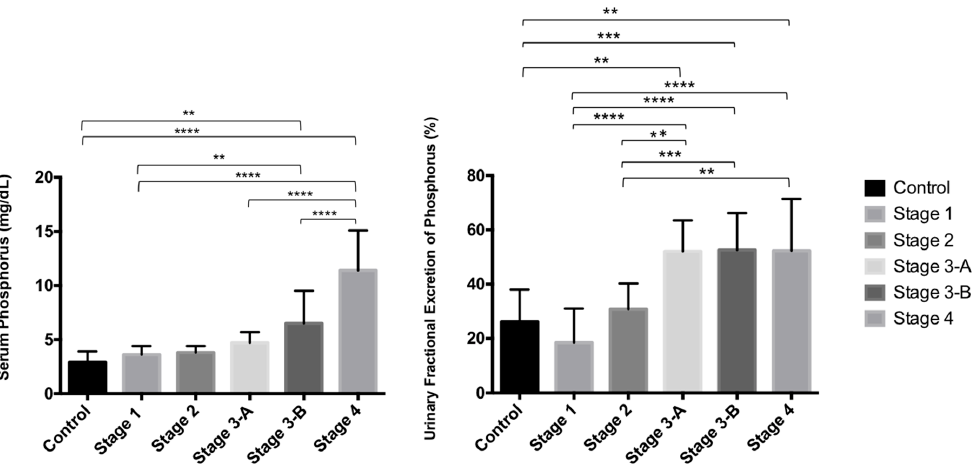
Figure 2. Data in graph are presented as mean ± standard deviation (SD) and statistical analysis ( p values—Turkey multiple comparison test) of serum phosphorus concentration (sP; mg/dL) and urinary fractional excretion of phosphorus (uFEP; %) in control dogs (C) and in dogs with chronic kidney disease with stage 1 (St 1), stage 2 (St 2), stage 3-A (St 3-A), stage 3-B (St 3-B) and stage 4 (St 4). ** p < 0.01; *** p < 0.001; **** p < 0.0001.